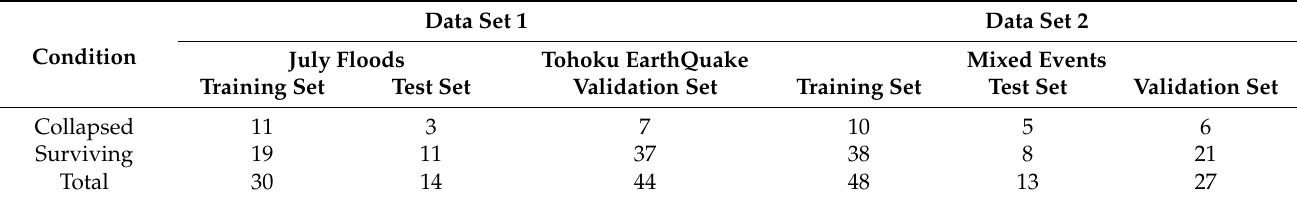
Table 3. Numbers of bridges used in the two data